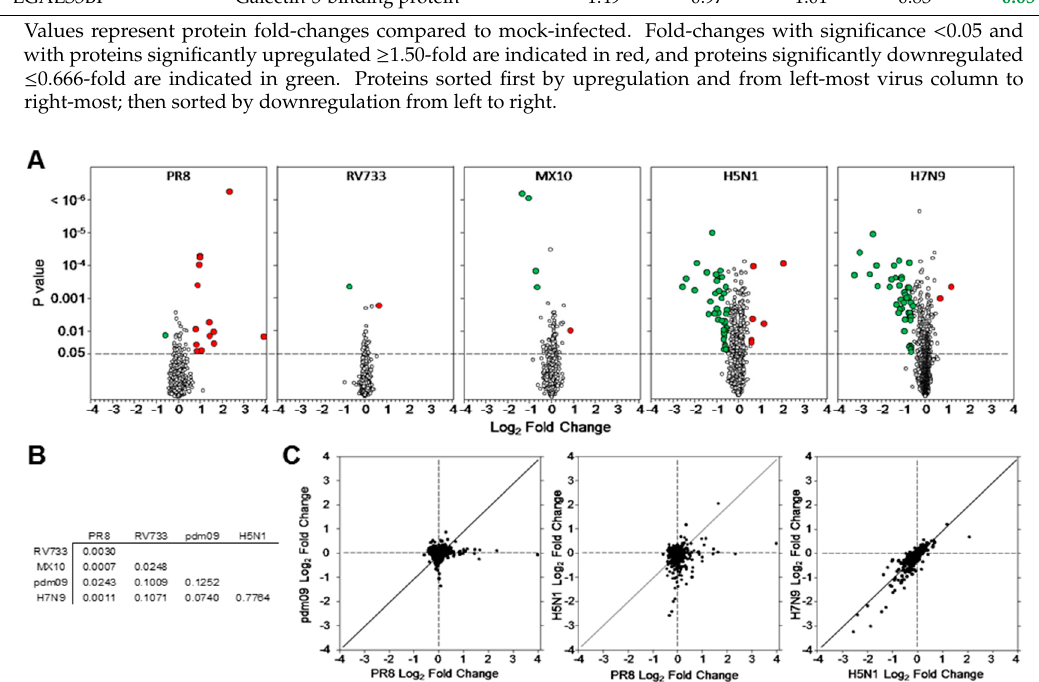
Figure 1. Protein dysregulation characteristics of IAV-infected A549 cells. ( A ) Volcano plots of dysregulated proteins. The dashed horizontal line corresponds to p -value 0.05. Proteins significantly upregulated ≥ 1.5-fold ( ≥ + 0.585 Log 2 ) are indicated with larger red circles and proteins downregulated ≥ 1.5-fold ( ≤− 0.585 Log 2 ) are indicated with larger green circles. ( B ) Pairwise R 2 comparisons of indicated virus-infected cellular proteins, with ( C ) Individual proteins of selected pairs graphically presented. Several immune-regulating proteins, including ISG15, OAS1 and STAT1 were upregulated by